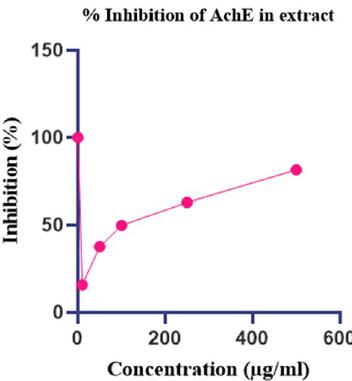
Fig. 7 Percentage inhibition of AchE in